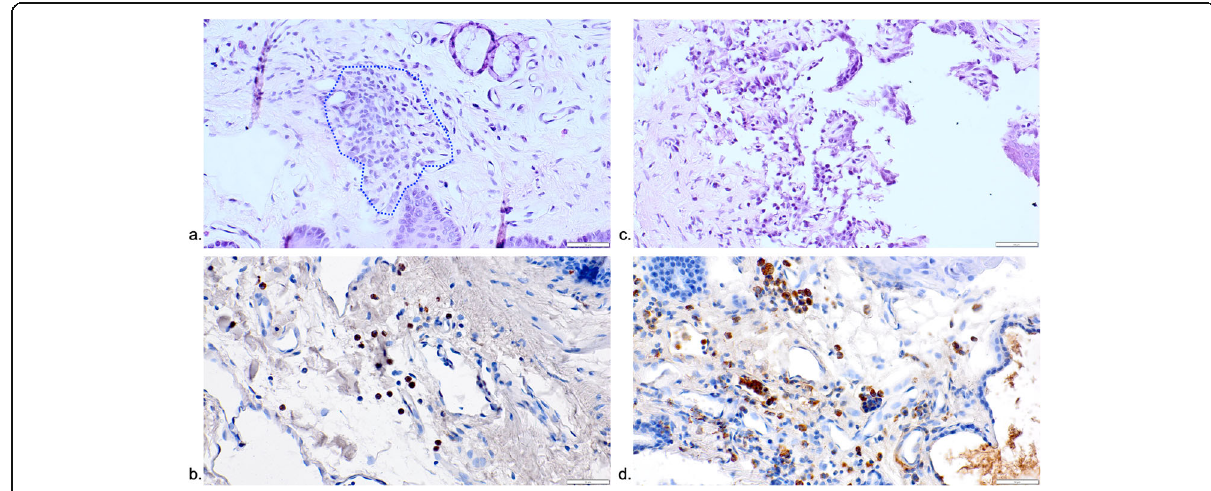
Fig. 3 Representative histological and immunohistochemical views of tissue reactions in the De and De+Be groups. a De specimens commonly presented with well discernible ICT areas that were larger in size (HE stain). b A higher frequency of CD68-positive cells was also commonly noted outside the ICT areas (De group). c An infiltration of the epithelial compartment associated with a surface ulceration was occasionally noted in both De groups (De+Be group). d Specimen showing a massive infiltration of the connective tissue compartment with CD68-positive cells (De+Be